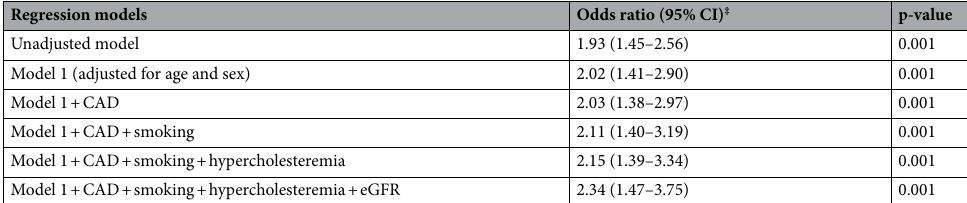
Table 3. Influence of individual factors on the odds ratios for PAD per one unit increase in normalized urinary fatty acid-binding protein 3. CAD coronary arterial disease, eGFR estimated glomerular filtration rate, CI confidence interval. ‡ Binary logistic regression models for PAD per one unit increase in